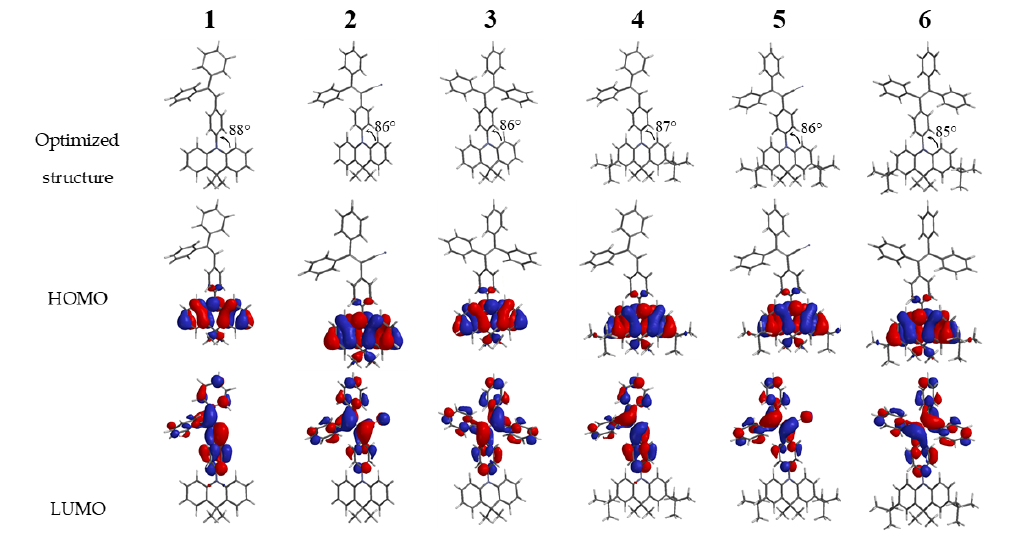
Figure 2. Spatial highest occupied molecular orbitals (HOMO) and lowest unoccupied molecular orbitals (LUMO) distributions for compounds 1 – 6 (DFT/B3LYP/6–31*). 2.4. Electrochemical and Photoelectrical